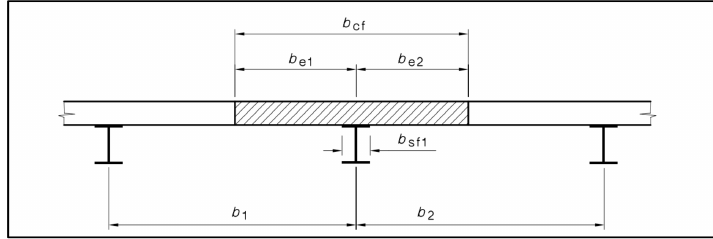
Figure 8. The effective width of composite steel–concrete internal beam